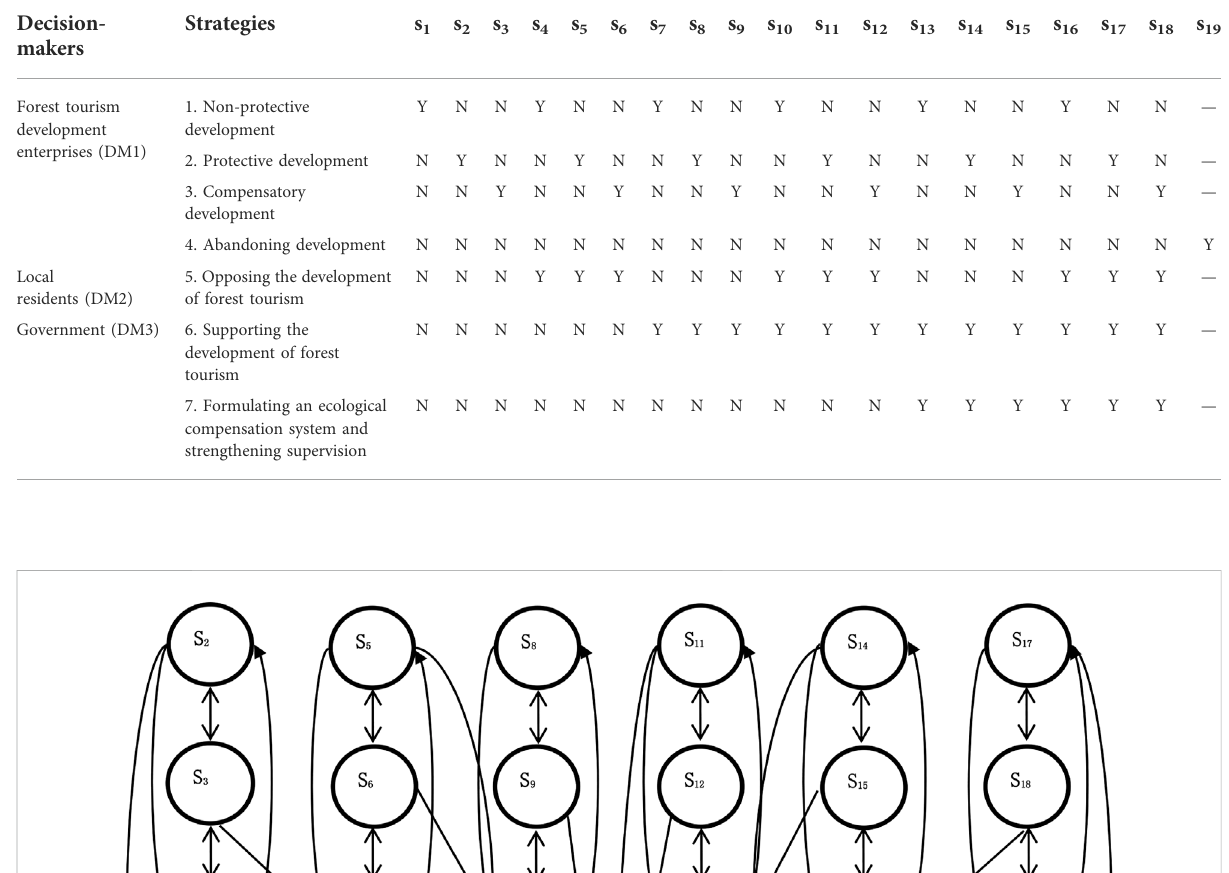
TABLE 1 Feasible state.